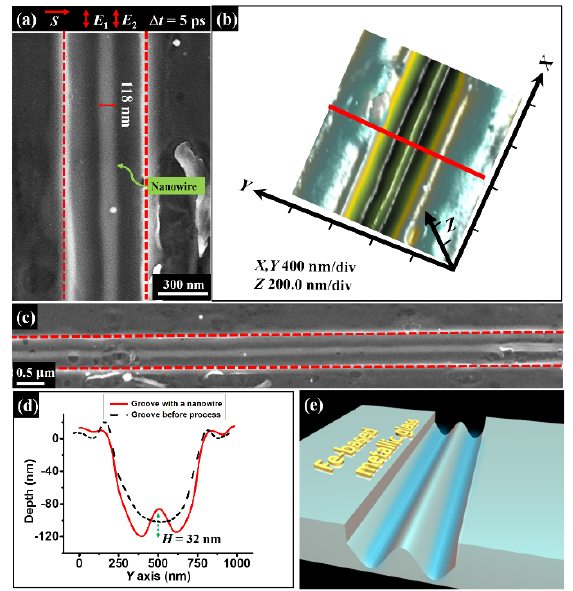
Figure 3. Observed formation of the sole long nanowire structure within the groove irradiated by double femtosecond lasers with the time delay of ∆ t = 5 ps, where the total energy fluence of two lasers is F = 30 mJ/cm 2 , and the scanning speed is v = 0.3 mm/s. ( a , b ) SEM image and three- dimensional AFM measurement of the sole nanowire structure inside the groove. Here E 1 and E 2 with the red double arrows represent the direction of the laser polarization, and S with the red single arrow for the sample translation direction. ( c ) SEM picture for the 10 μ m length of the sole nanowire structure. ( d ) Measured cross-section curves for the groove before (black line) and after (red line) the femtosecond laser irradiation. ( e ) A diagram of the nanowire structure formation inside the groove, where the blue color lines represent the interfering intensity fringes between the femtosecond laser and TE polarized magnetic surface wave inside the groove.